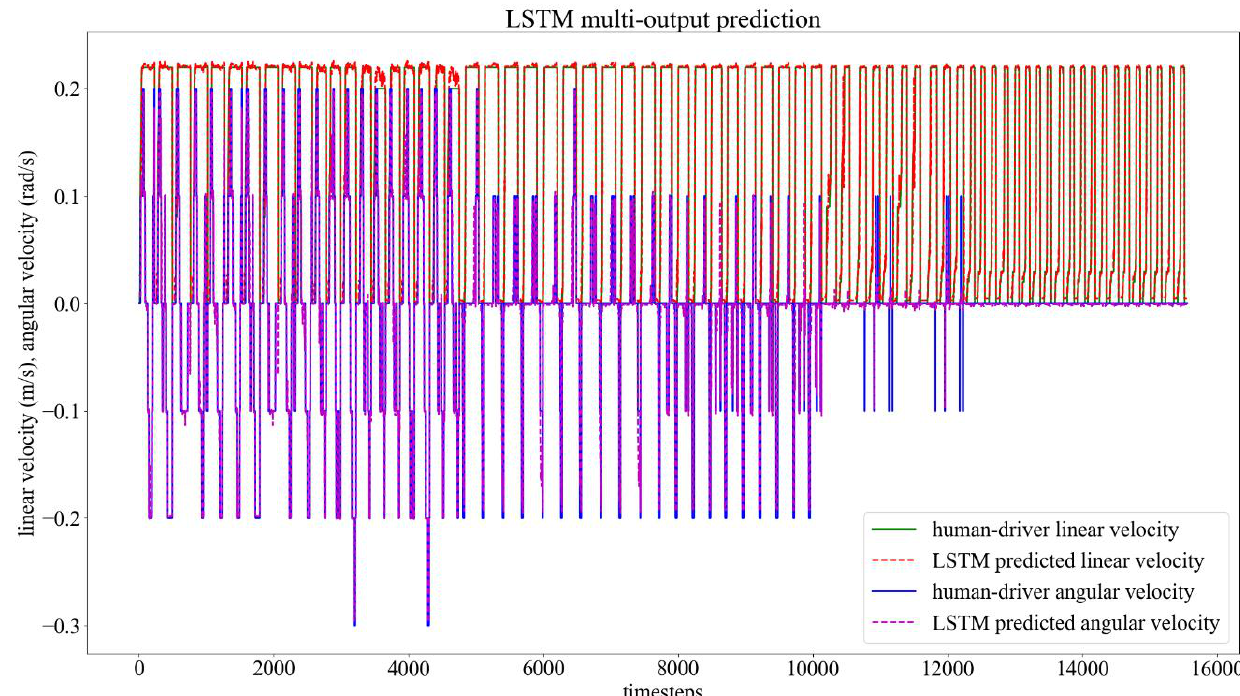
Figure 10. Velocity commands for several trajectories given by the user for training.